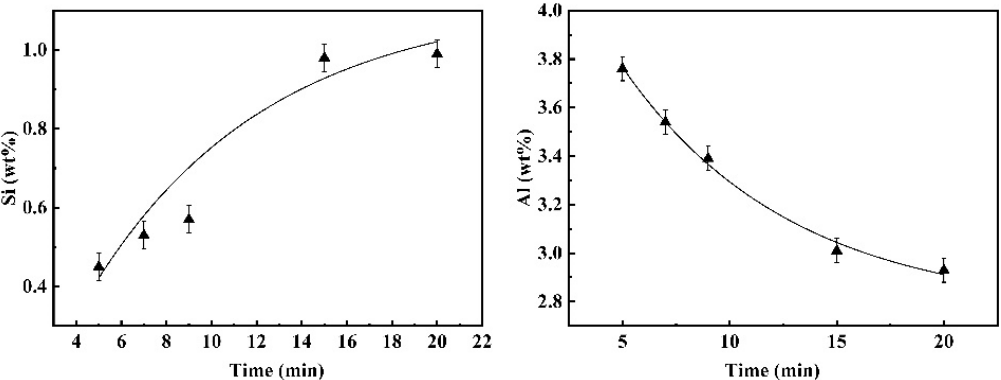
Figure 18. Composition change of molten steel during reaction between Fe-13Mn-5Al alloy and molten flux.